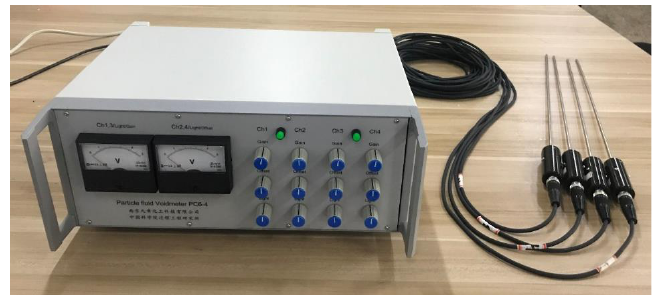
Figure 2. PC-6M particle concentration analyzer.